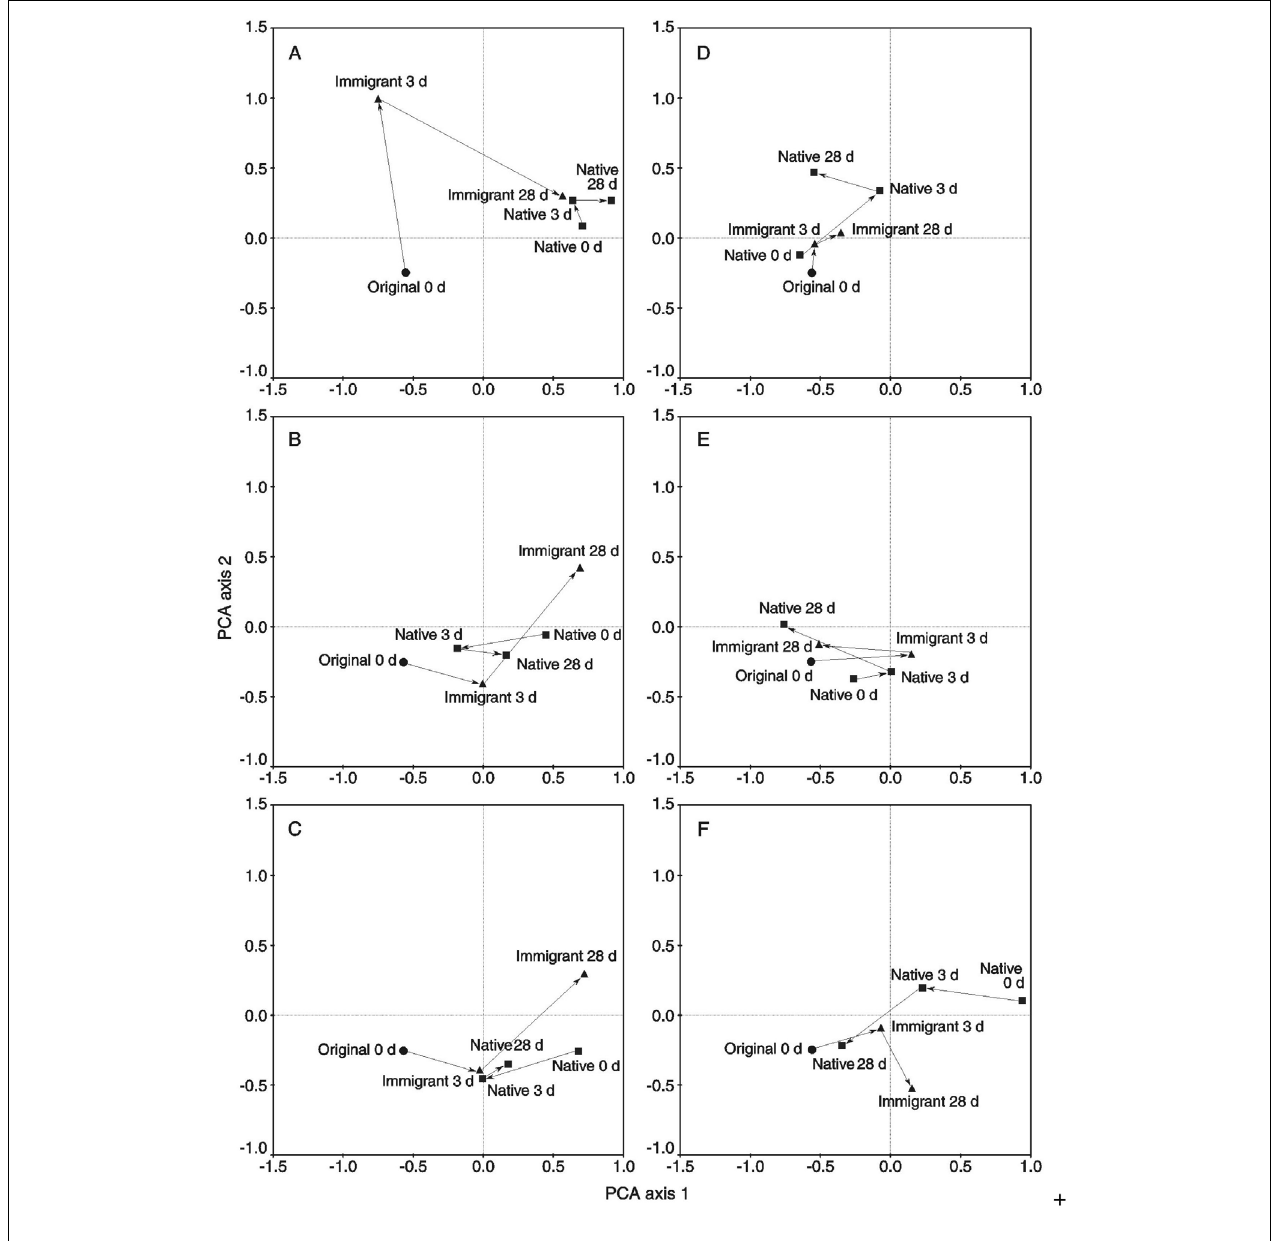
immigrant = original moss transplanted to the active flark site, native = native moss of the active flark site). The first and second PCA axes explain 25 and 11% of the compositional variation,